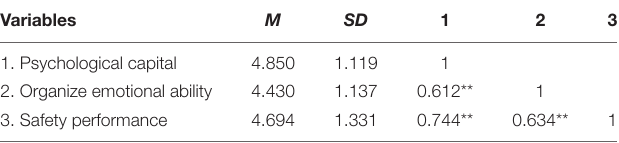
TABLE 6 | | Means, standard deviations, and correlation coefficients of variables. Variables